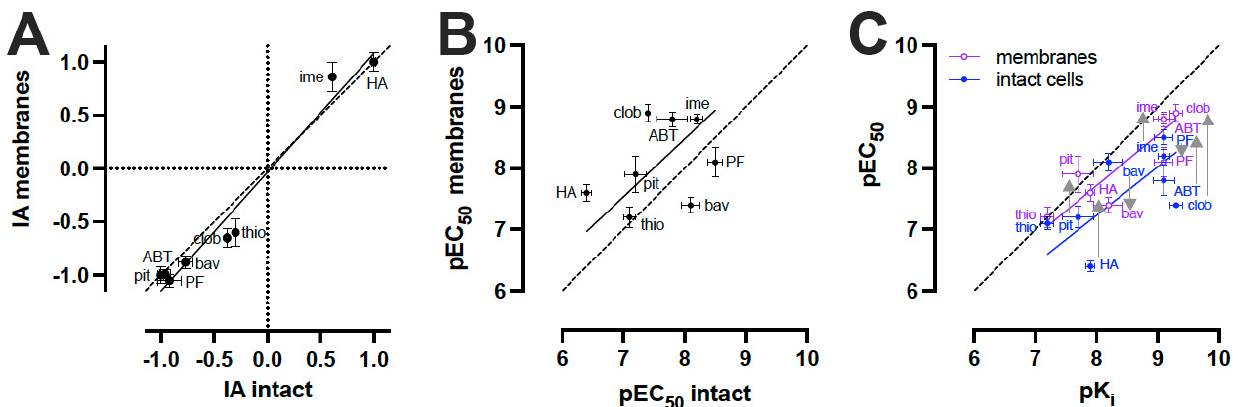
Figure 4. Comparison of H 3 R biosensor pharmacology on intact cells versus membrane preparations in response to H 3 R ligands. ( A , B ) Comparison of intrinsic activity (IA) values ( A ) and pEC 50 ( B ) obtained from H 3 R biosensor in intact cells versus membrane preparations upon stimulation with increasing ligand concentrations for 30 min (see Figures 1C and 3D; Table 1). ( C ) Comparison of pK i values obtained from radioligand competition binding experiments on H 3 R biosensor-expressing membranes in 50 mM Tris-HCl (pH 7.4) with pEC 50 values obtained from H 3 R biosensors in intact cells (in HBSS) and membrane preparations (in 50 mM Tris-HCl (pH 7.4)) upon stimulation with increasing ligand concentrations for 30 min (see Figures 1C and 3D; Table 1). Differences between pEC 50 values obtained from H 3 R biosensor in intact cells versus membrane preparations are indicated with grey arrows. Data are displayed as mean ± SD from at least 3 independent experiments performed in duplicate. Deming linear regression was used to compare the fitted affinity and/or potency values between the different assay formats, the dotted line represents line of unity ( B , C ). HA = histamine; ime = imetit; pit = pitolisant; clob = clobenpropit; thio = thioperamide; bav = bavisant; ABT = ABT-239; PF =